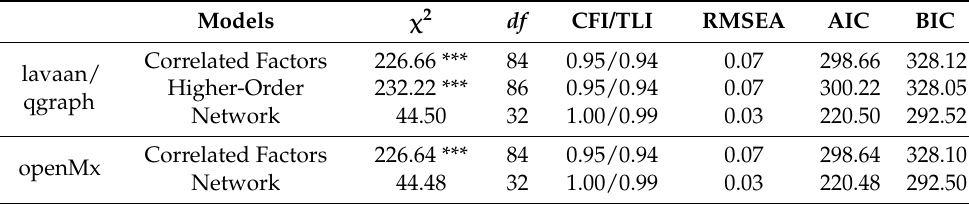
FW = figure weights; C = comparisons; Ca = cancellation; PC = picture completion. N = 400. Table 4. Model fit for latent variable and network models of WAIS-IV correlations (young